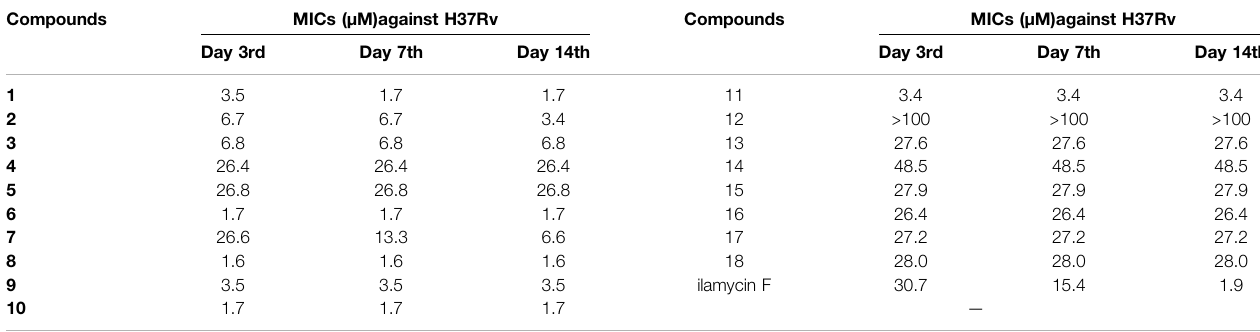
TABLE 1 | Anti-tubercular activity of ilamycin NJLs ( 1 – 18 ) against M. tuberculosis H37Rv.